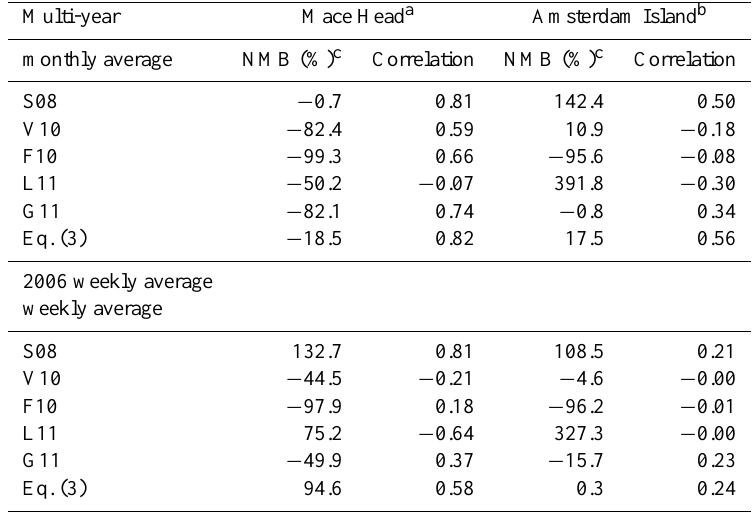
a 2006 Mace Head concentrations (lower half of table) are WIOM+uncharacterized WSOM b PM 1 :PM bulk ratio of 0.41 taken from Claeys et al. (2009) WIOM PM 2 . 5 :PM 10